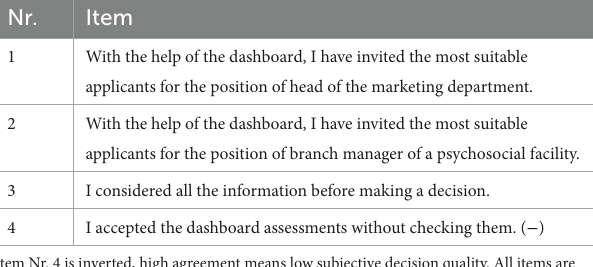
TABLE 2 Scale for subjective decision quality.